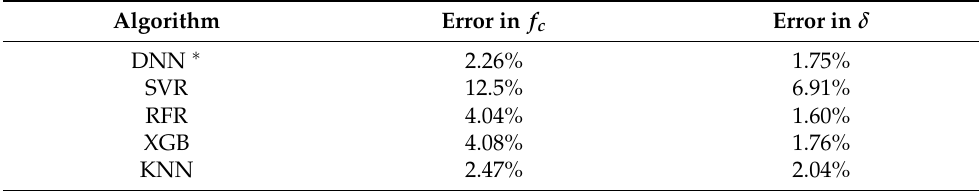
Table 2. Baseline comparison between the proposed deep neural network (DNN) approach and four alternative machine learning algorithms. The performance of each algorithm was evaluated by the errors in f c and δ comparing the obtained band gap (forward calculation using the design parameters output from each algorithm) with the desired band gap. ( ∗ denotes the proposed approach.)